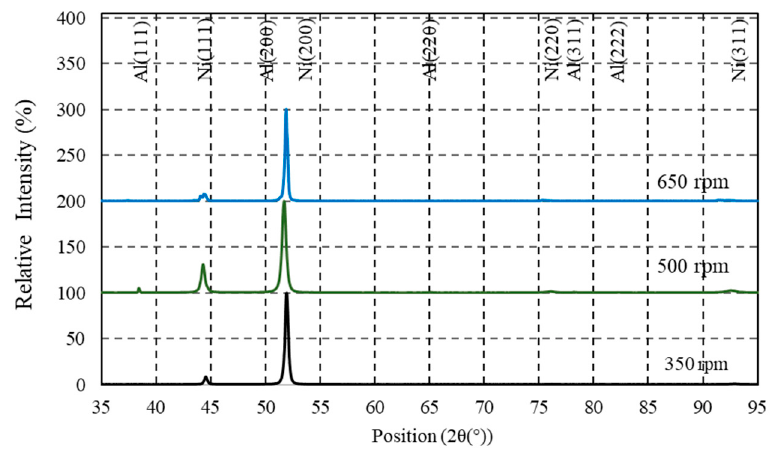
Figure 11. XRD patterns of coatings obtained with the conditions mentioned in the caption of Figure 9.